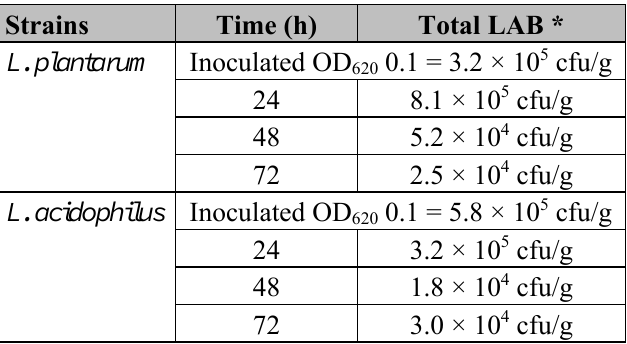
Table 3(a). Total LAB of SSF.